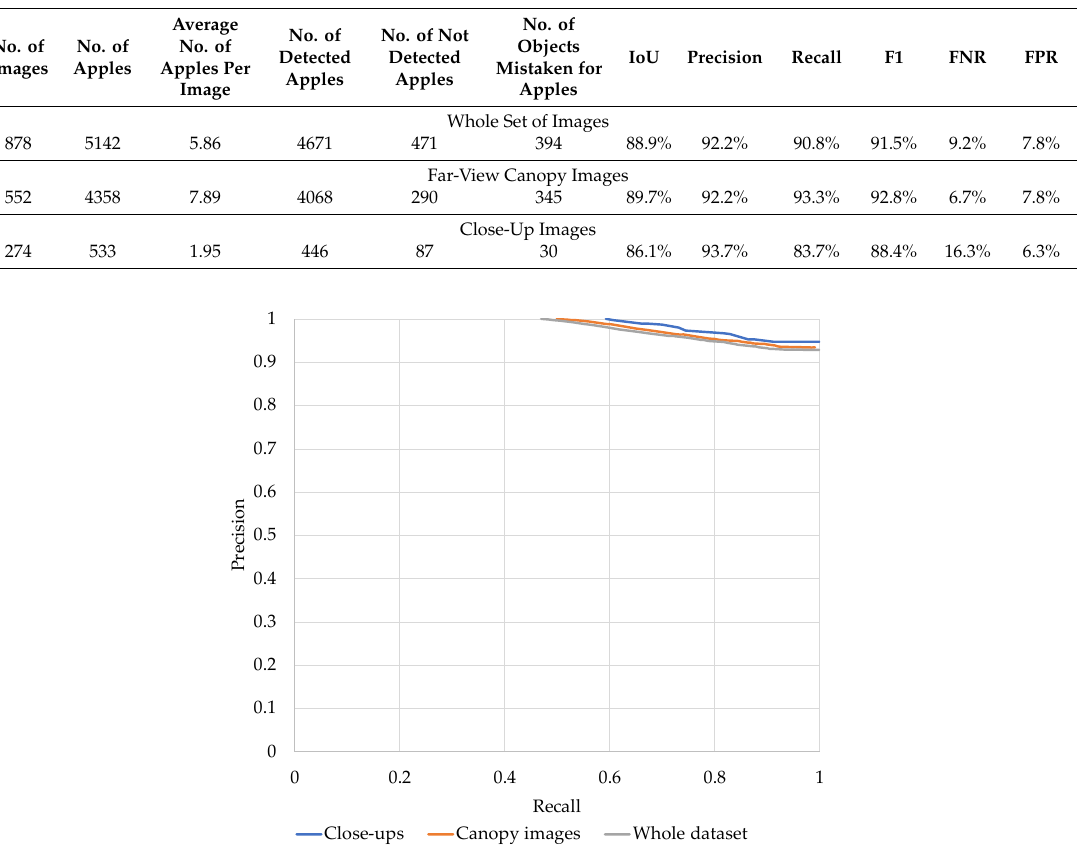
Table 2. Apple detection quality metrics.